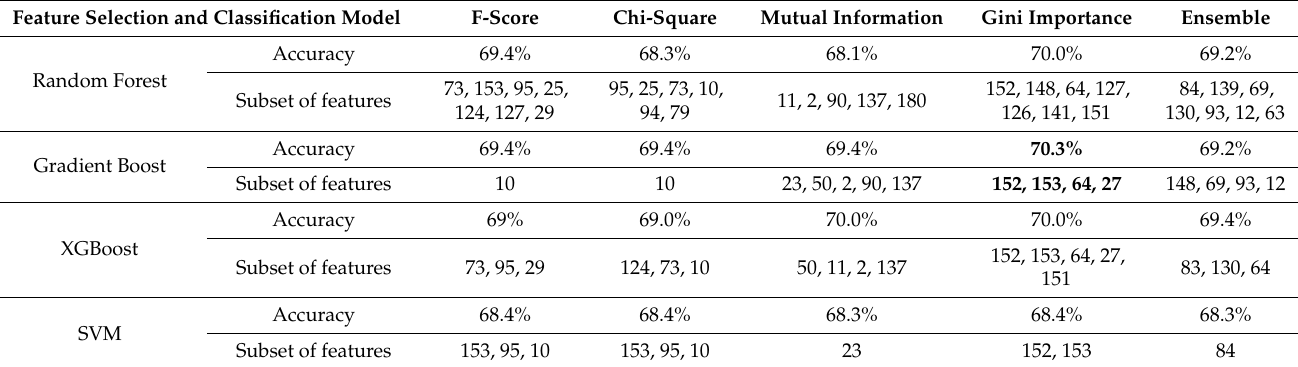
Table 4. The result of constructing a combination using 10 main features and extracting the feature with the highest classification